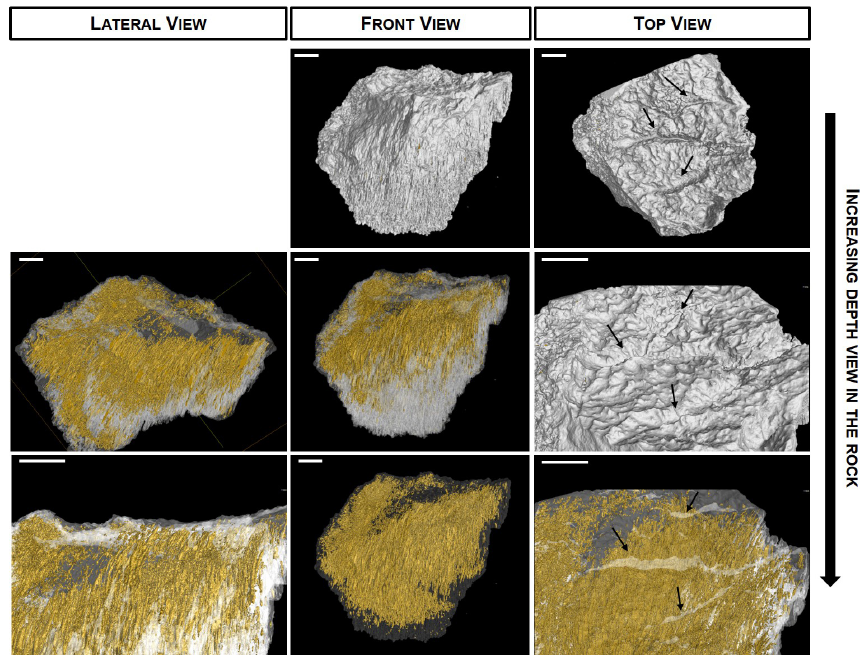
Figure 2. CT-scan images of a colonized piece of gypcrete. The 3D reconstruction of a gypcrete sample with the spatial distribution of pores (yellow colour) and complete reconstructions of the scanned volume (grey colour) on lateral, front and top views of gypcrete. Porous micromorphology is capillary-shaped in the vertical direction due to movement of the water by gravity. Arrows in top-view images point to the deepest cracks. Scale bars are